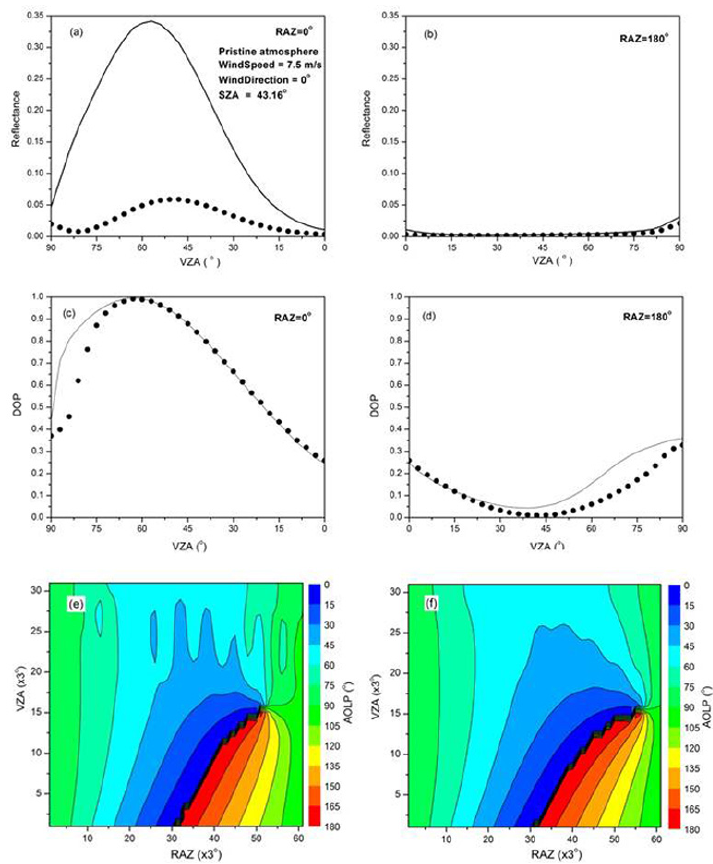
Fig. 7. The total reflectance, DOP, and AOLP at a wavelength of 1200nm at TOA, which is calculated with the ADRTM at a solar zenith angle of 43.16 ◦ over a pristine clear-sky ocean with a wind speed of 7.5ms − 1 and a wind direction of 0 ◦ . Solid curves denote the total reflectance and DOP with the sub-Arctic winter (SAW) atmosphere. Black dots denote the total reflectance and DOP with the tropical (TPC) atmosphere. Panel (e) shows the AOLP with SAW atmosphere and (f) shows the AOLP with TPC